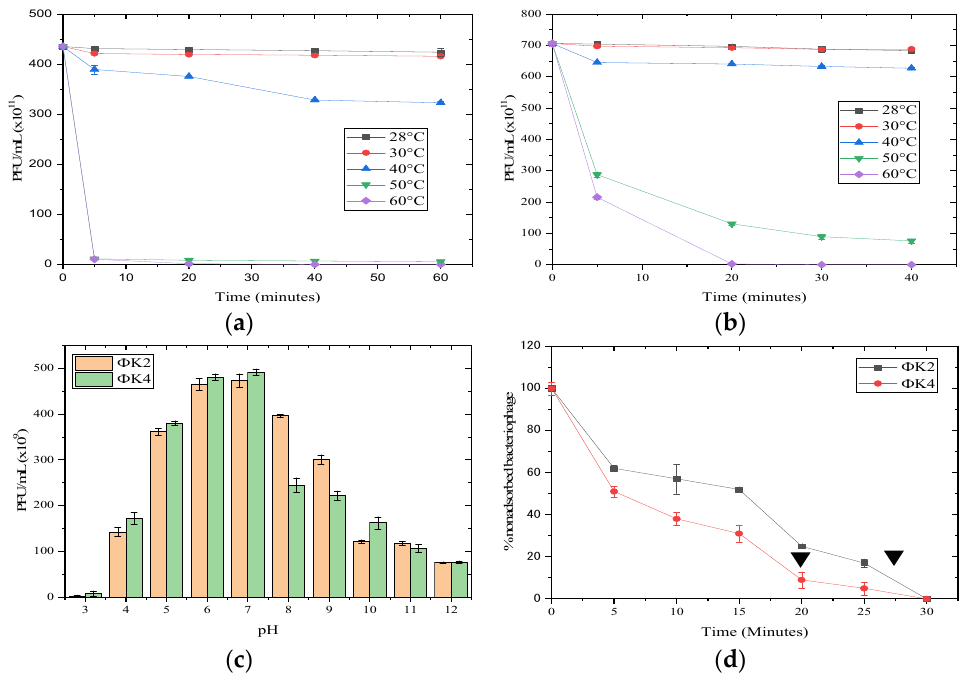
Figure 3. The rate of adsorption and the pH and thermal stability of Φ K2 and Φ K4: ( a ) thermal stability of Φ K2; ( b ) thermal stability of Φ K4; ( c ) pH stability of Φ K2 and Φ K4; ( d ) adsorption of Φ K2 and Φ K4 to the A. tumefaciens AGL1 WT host. The black arrow indicates the optimal adsorption value. Results are presented as mean values ± SD.